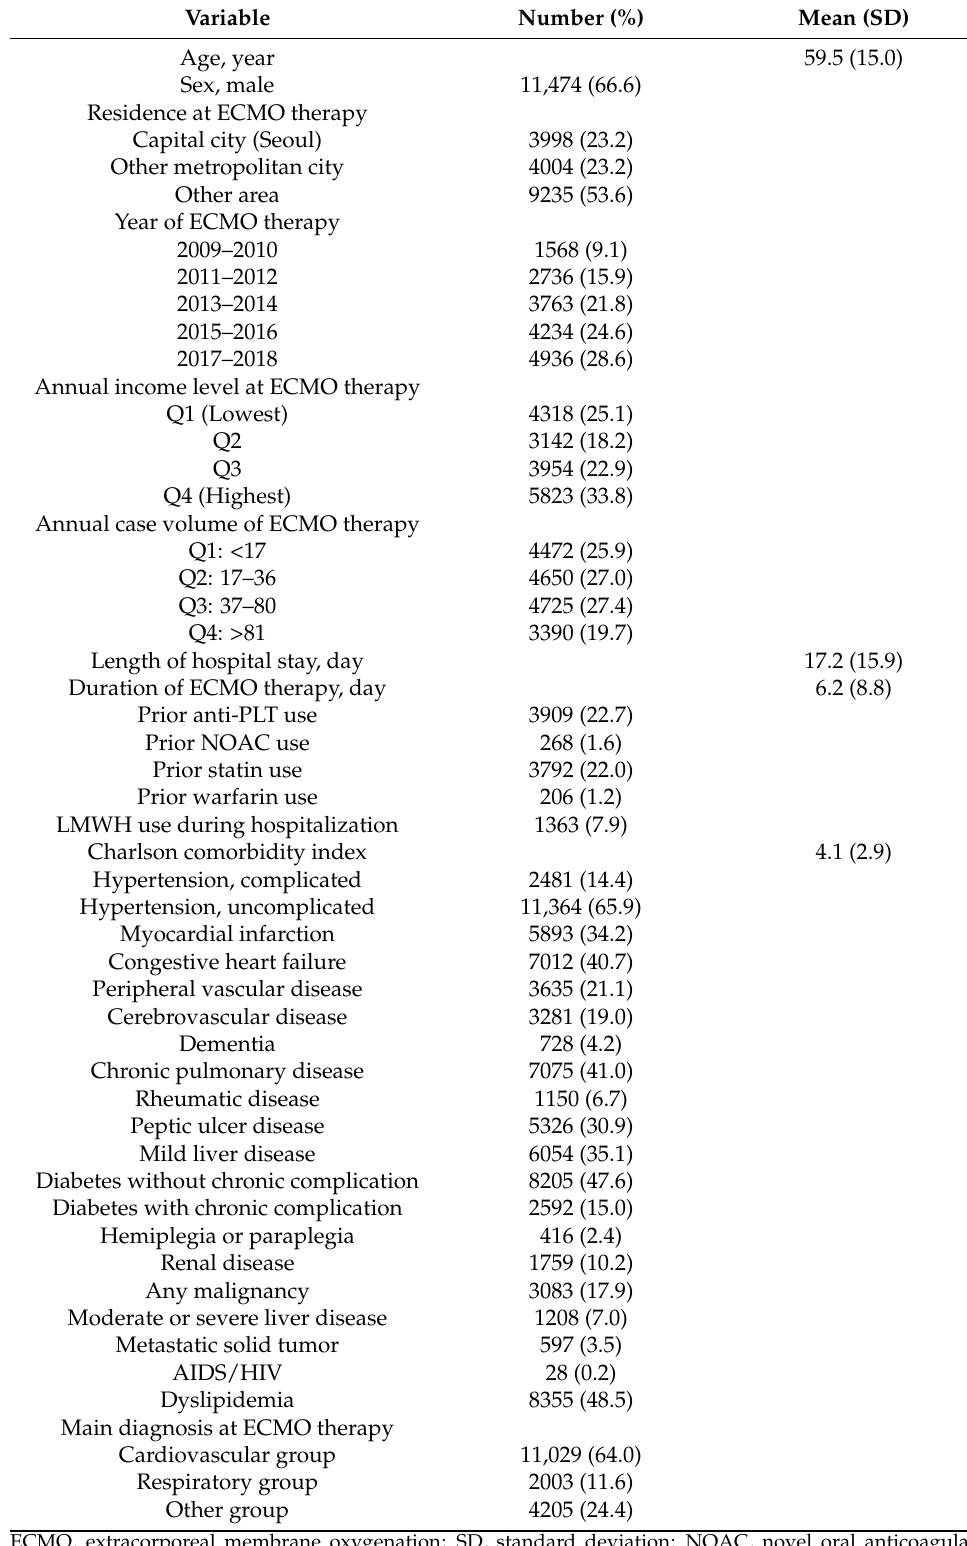
Table 1. Clinicoepidemiological characteristics of patients undergoing